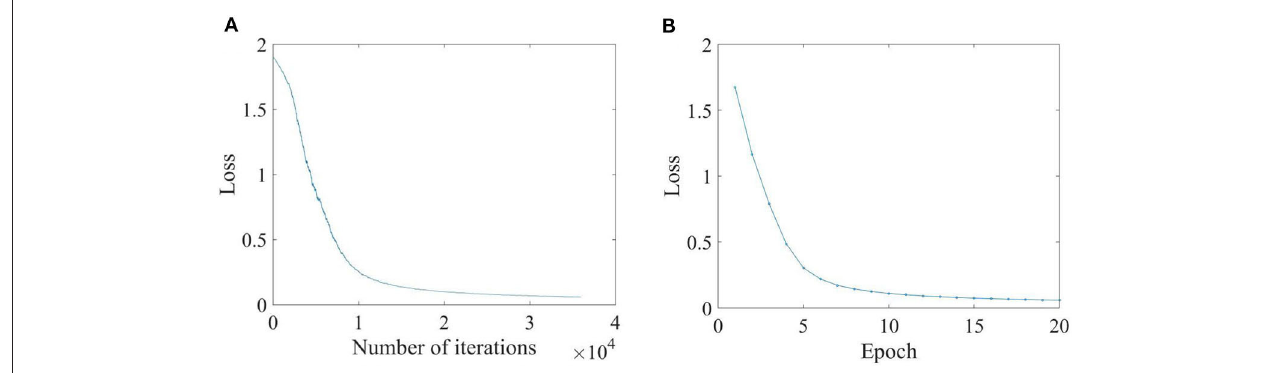
FIGURE 15 | The train and validation losses during the CNN training process. (A) Train losses over iterations. (B) Validation losses over